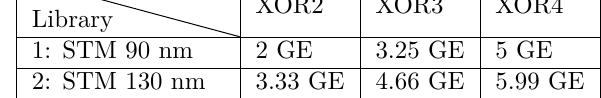
Figure 1: Two implementations of ( y 0 , y 1 ) T = M 1 × ( x 0 , x 1 , x 2 , x 3 ) T